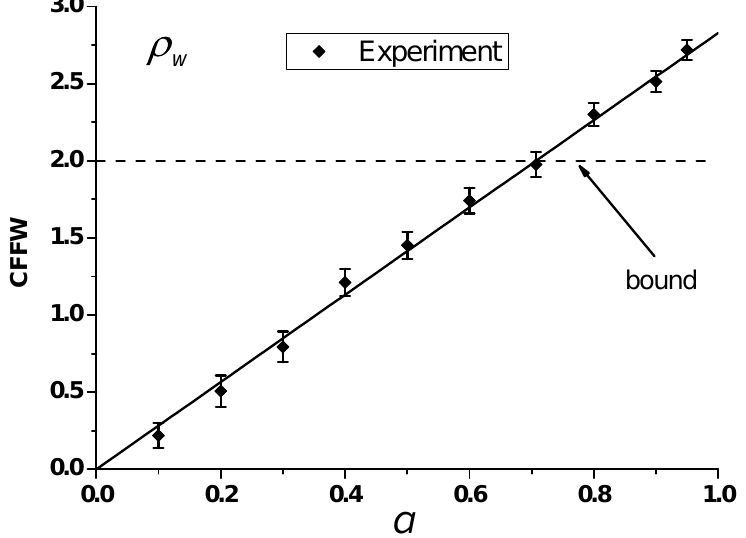
Figure 5. Experimental violations of CFFW inequality as a function of the state decoherence coefficient a for different Werner states ρ w . The diamond symbols represent the experimental data. The solid line represents the theoretical prediction. The dashed line represents the bound of violation of the CFFW inequality. Error bars are due to statistical uncertainty. The experimental results match well with theoretical predictions.